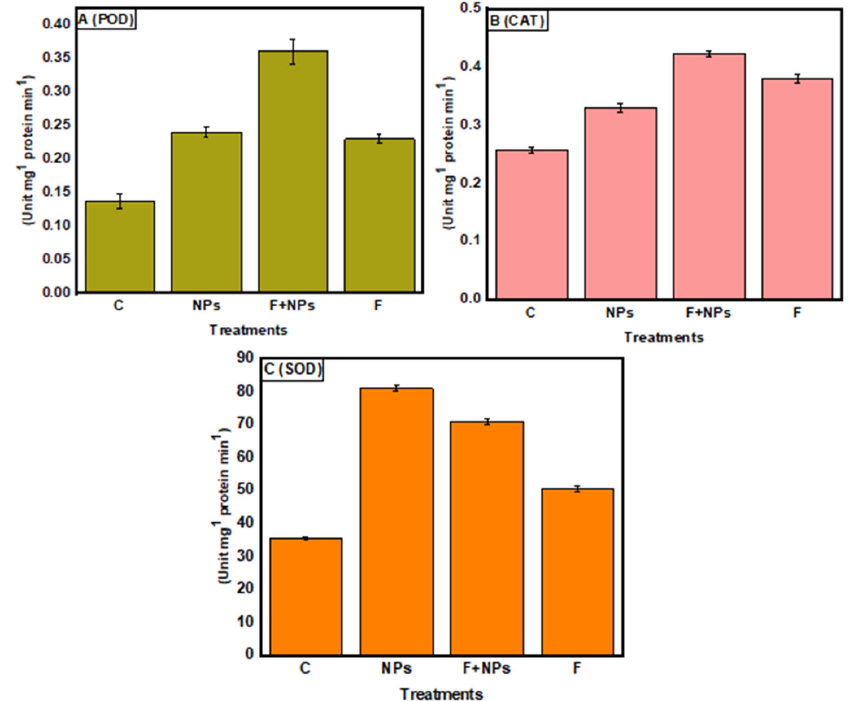
Figure 17. Peroxidase (POD) activity ( A ), catalase activity ( B ) and superoxide dismutase (SOD) activity ( C ) of chickpea under different growth conditions. C = control (without fungus), NPs = seeds primed with 0.5 μ g/mL ZnO NPs, NPs + F = seeds primed with 0.5 μ g/mL ZnO NPs and sown in fungus inoculated soil, F = seeds sown in fungus inoculated soil.